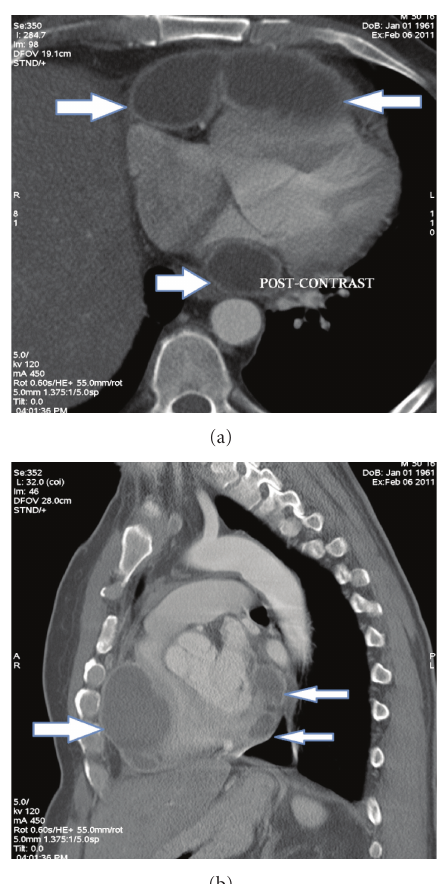
Figure 1: CT scan of chest shows the cysts compressing the right ventricle anteriorly (large arrows) and the cyst behind the heart compressing the left atrium posteriorly (small arrows).